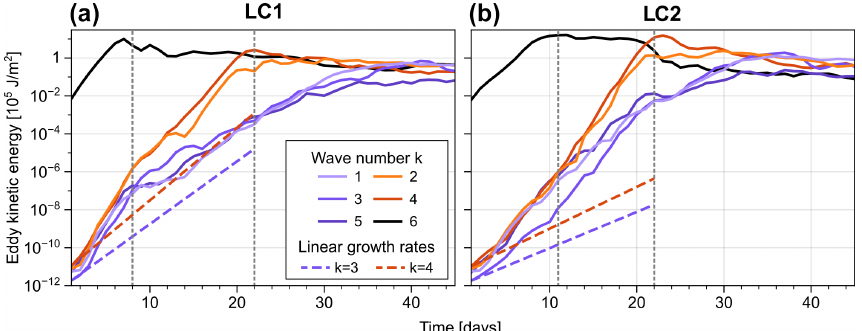
Figure 6. Evolution of EKE for selected wave numbers in experiments with LC1 and LC2 initial conditions and weak initial noise ( η = 10 − 3 ) as average over 11 realisations. Sloped dashed lines indicate theoretical EKE growth with growth rates diagnosed from reference simulations with initial perturbations of specified single wave numbers 3 and 4, respectively. Vertical dotted lines indicate transitions between stages characterised by different types of wave–wave